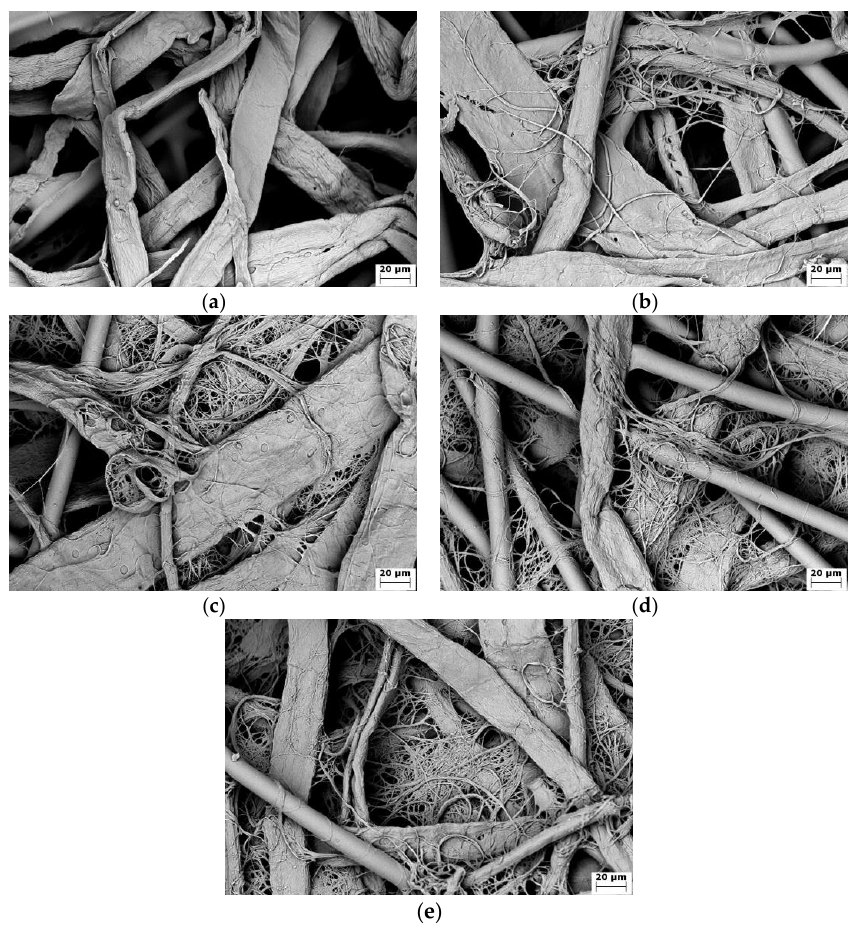
Figure 5. SEM images of filter paper containing different amounts of nanofibers: ( a ) sample #1; ( b ) sample #2; ( c ) sample #3; ( d ) sample #4; ( e ) sample #5. ( b ) sample #2; ( c ) sample #3; ( d ) sample #4; ( e ) sample